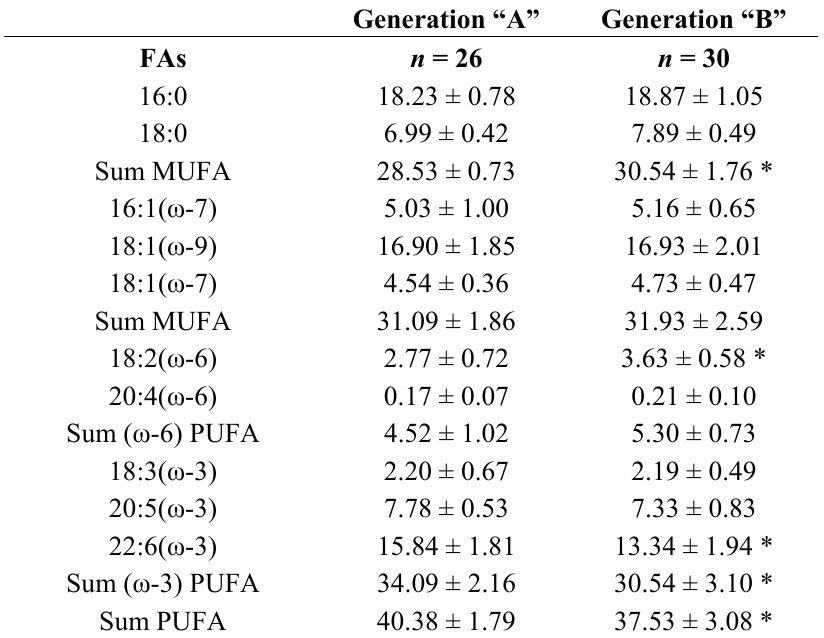
Table 3. Fatty acids (FA) composition (% of total FAs) of the fingerlings of salmon from two